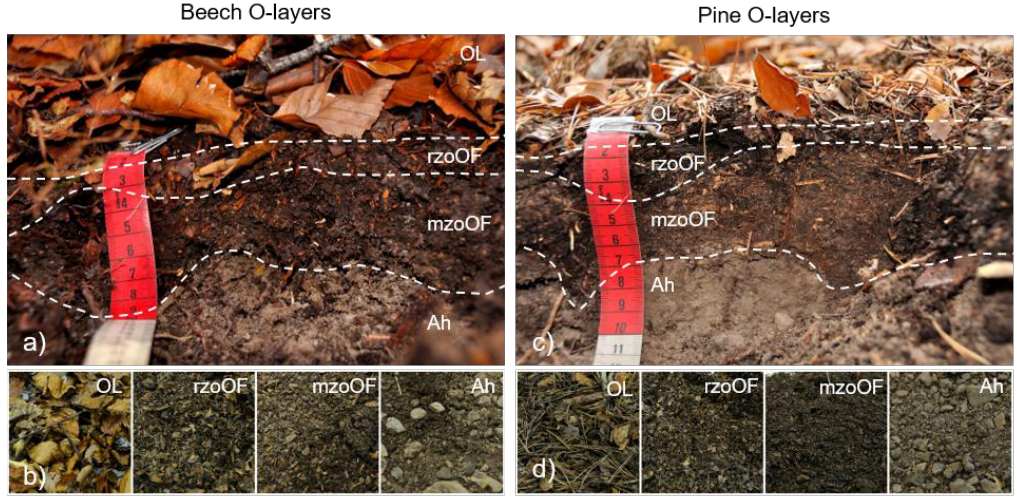
Figure 3. Morphology of the organic layers observed in the European beech ( a , b ) and the Scots pine ( c , d )